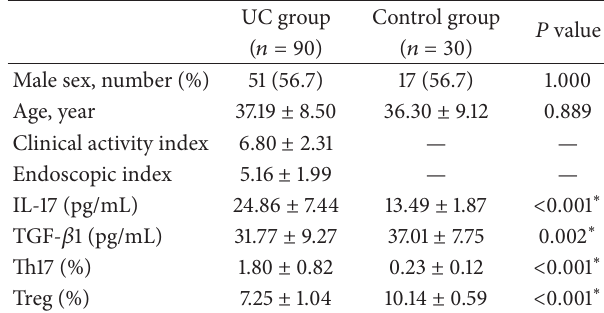
Table 1: Demographic details and clinical characteristics of UC patients and healthy subjects.